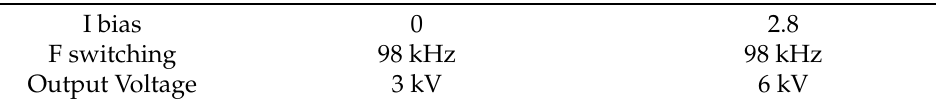
Figure 13. High voltage output. Table 2. Experimental